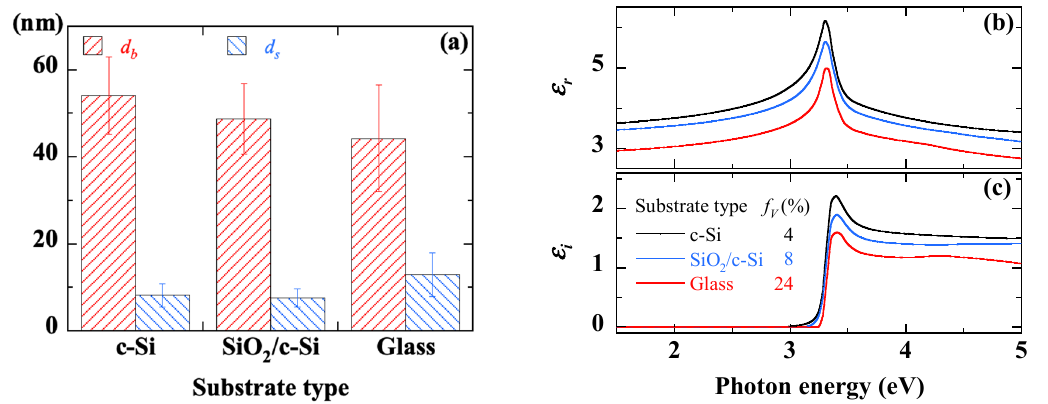
Figure 14. Thickness of the bulk layer ( a ) and the surface roughness ( b ), real ( c ) and imaginary ( d ) parts of the dielectric function extracted from SE measurements on sol-gel spin-coated ZnO thin films deposited on different substrates.